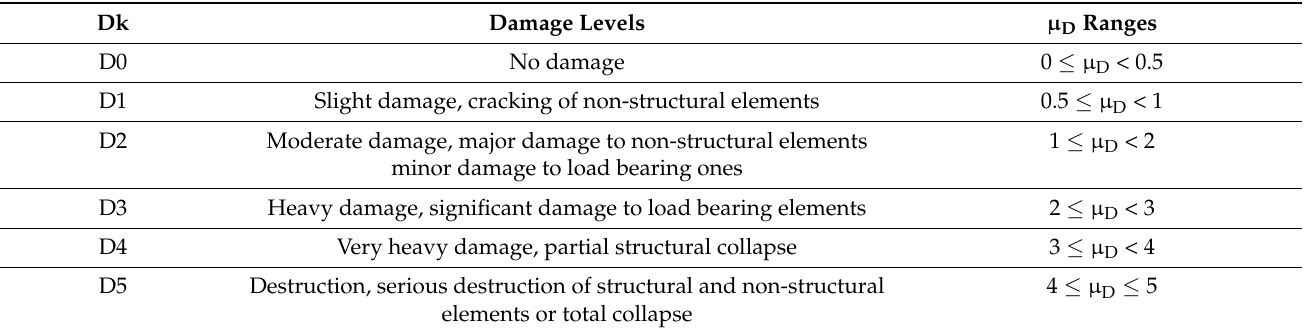
Table 1. Attribution of damage levels Dk (k = 0–5) based on µ D ranges resulting from Equation (2).